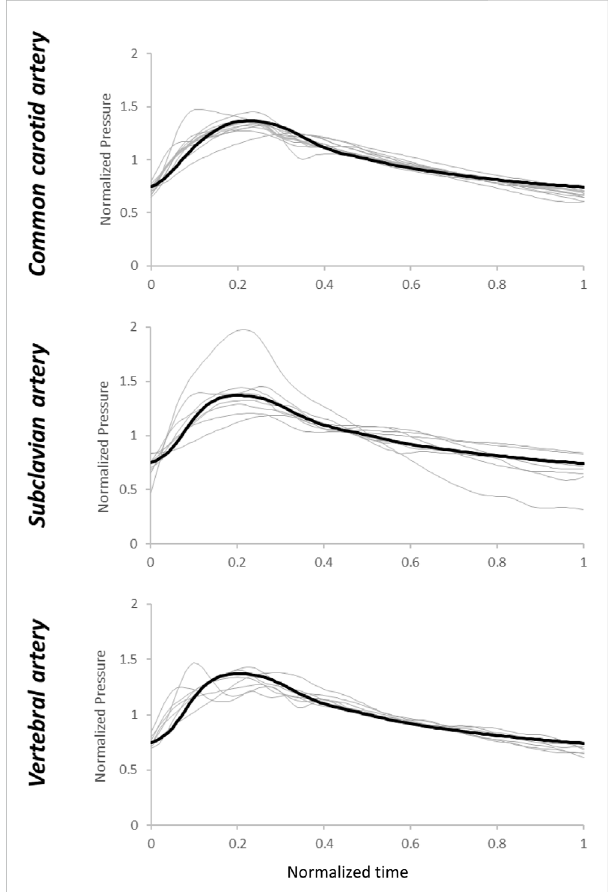
FIGURE 3 Estimated pressure waveforms using patient-speci fi c, pre- operative input fl ow rate waveforms. The black line represents the average of the measured waveforms. Normalization has been performed post-simulation for comparison purposes.